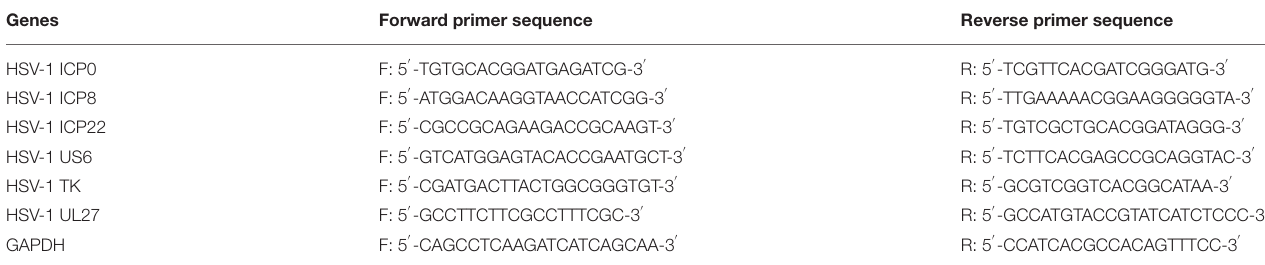
TABLE 1 | Primers used for RT-qPCR in this study. Genes Forward primer sequence Reverse primer